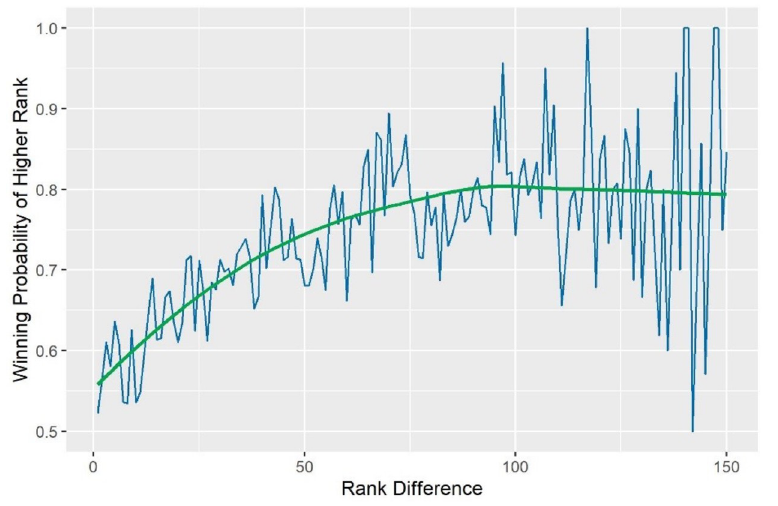
Fig 2. Winning probability of higher-ranked player vs. rank difference (male single).